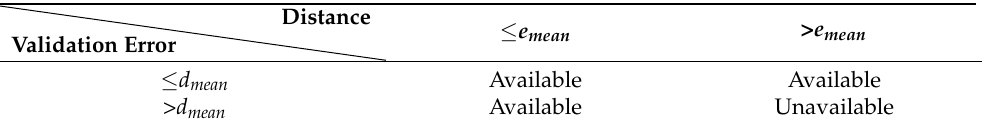
Table 1. Beacon node filter